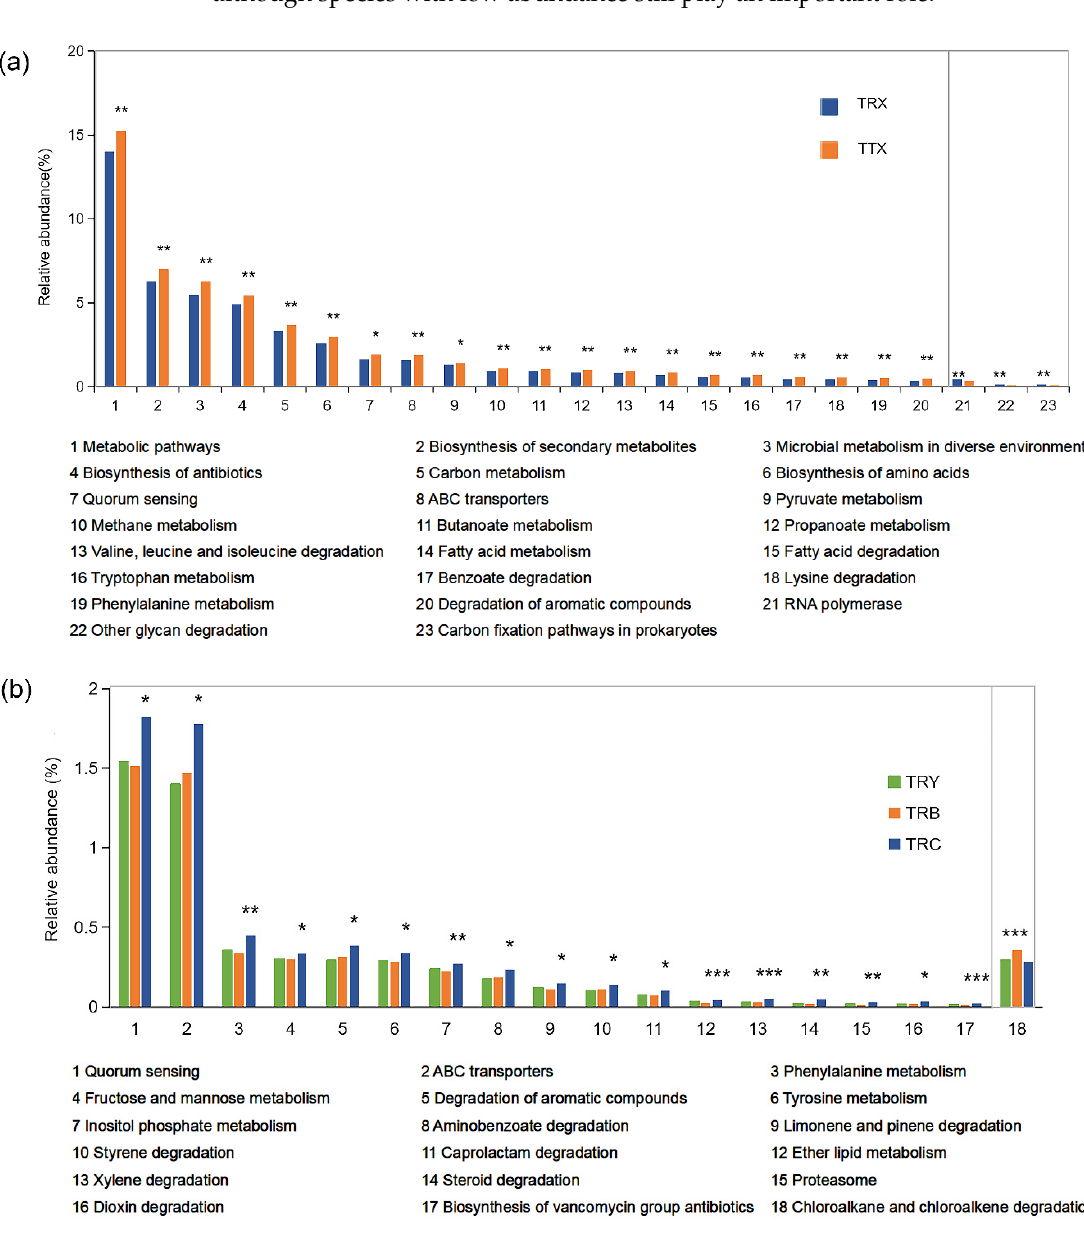
Figure 6. Differences functional composition of rhizosphere microbiome in C. henryi . ( a ) The pairwise comparison difference at KEGG level 3 pathways were calculated with Wilcoxon rank-sum test. TRX stands for plantation. ( b ) The multiple comparisons comparison difference at KEGG level 3 pathways were calculated with Kruskal–Wallis rank-sum test. * Correlation is significant at p < 0.05; ** Correlation is significant at p < 0.01; *** Correlation is significant at p < 0.001. TRY, TRC, and TRB, three cultivated varieties of plantation; TTX, natural forest; TRX, plantation.